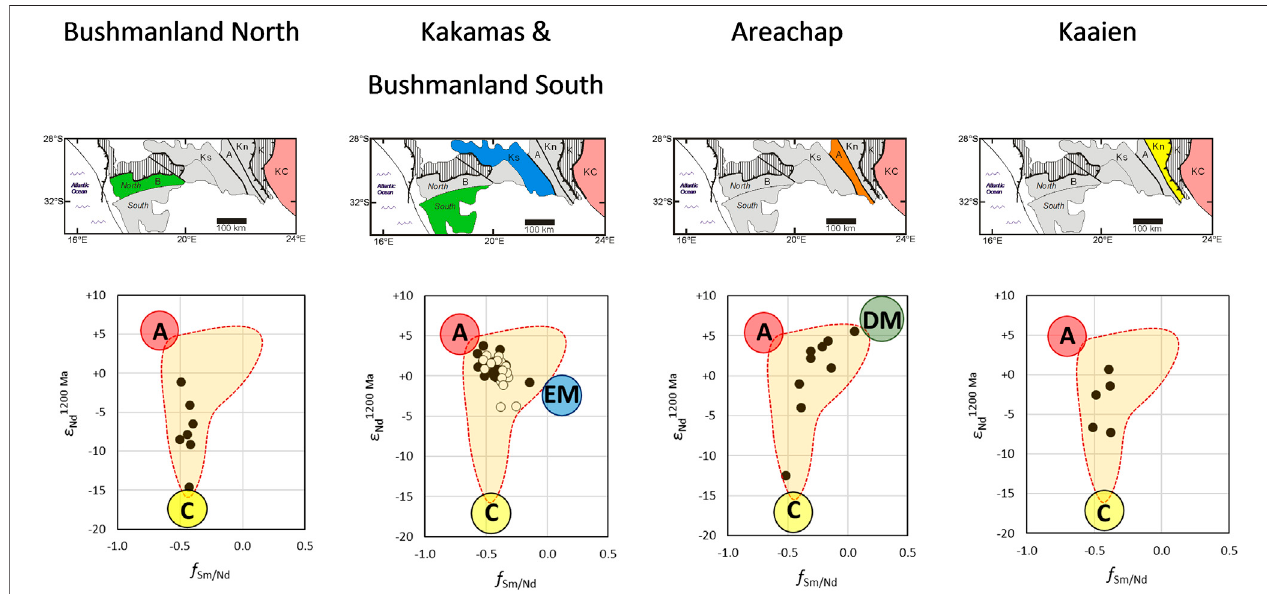
FIGURE 13 | Source variation with geographic position and different domains. Bushmanland North data from Yuhara et al. (2002) and Pettersson et al. (2009); Bushmanland South data from Yuhara et al. (2002), Pettersson et al. (2009), and Bailie et al.(2019); Kakamas(Ks) data from Bailie et al. (2017) and this study; Areachap and Kaaien data from Pettersson et al. (2009). B, Bushmanland; Ks, Kakamas; A, Areachap; Kn, Kaaien; K, Kheis; KC, Kaapvaal Craton. Vertically-lined fi elds are 2.4 – 2.2 Ga pre-Namaquan regions (see also Figure 1 ). Granite magma sources: A, anorogenic granite source; C, Paleo-/Mesoproterozoic crust; EM, enriched mantle; DM, depleted